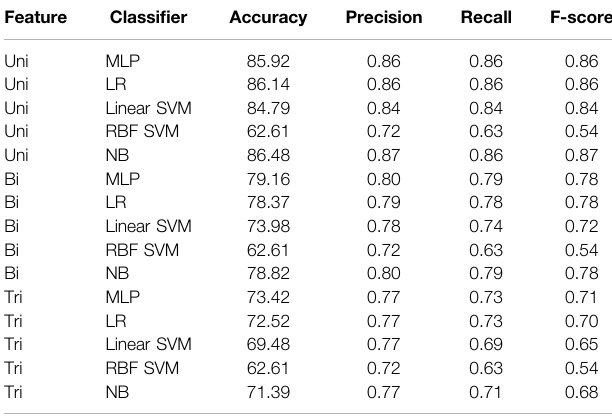
TABLE 3 | Results of N-gram features.